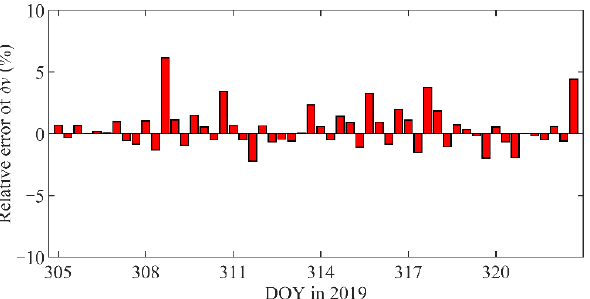
Figure 10. Relative errors of velocity changes obtained by BDS2 ‐ based POD wrt those by GPS.